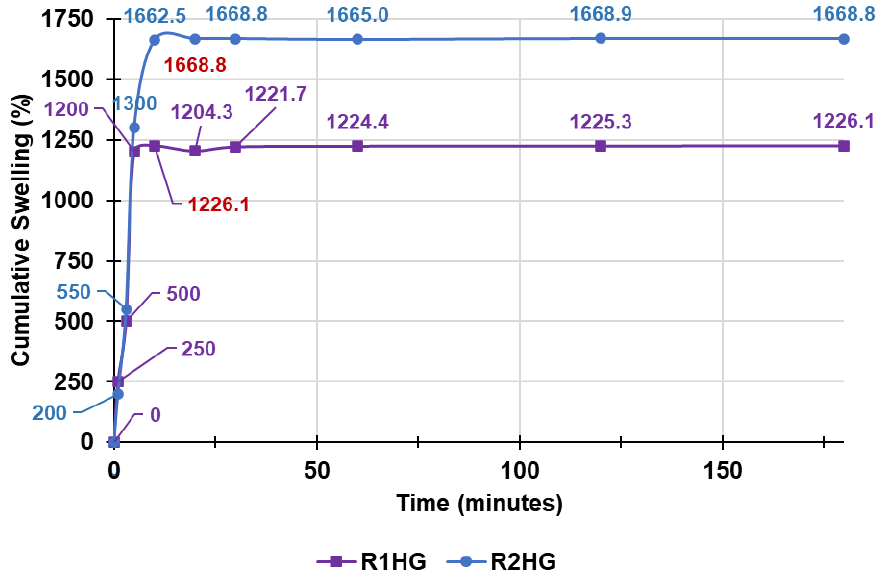
Figure 7. Cumulative swelling ratio percentage curves of R1HG and R2HG. The experiments were performed at r.t. Red numbers correspond to Q equil .